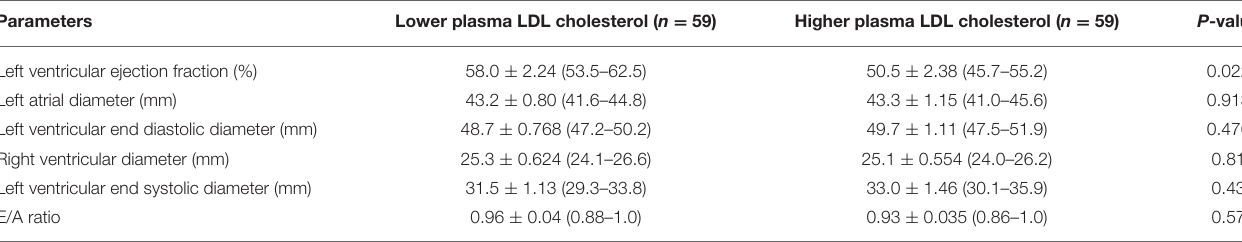
TABLE 2 | Association between plasma low-density lipoprotein cholesterol and left ventricular function. Parameters